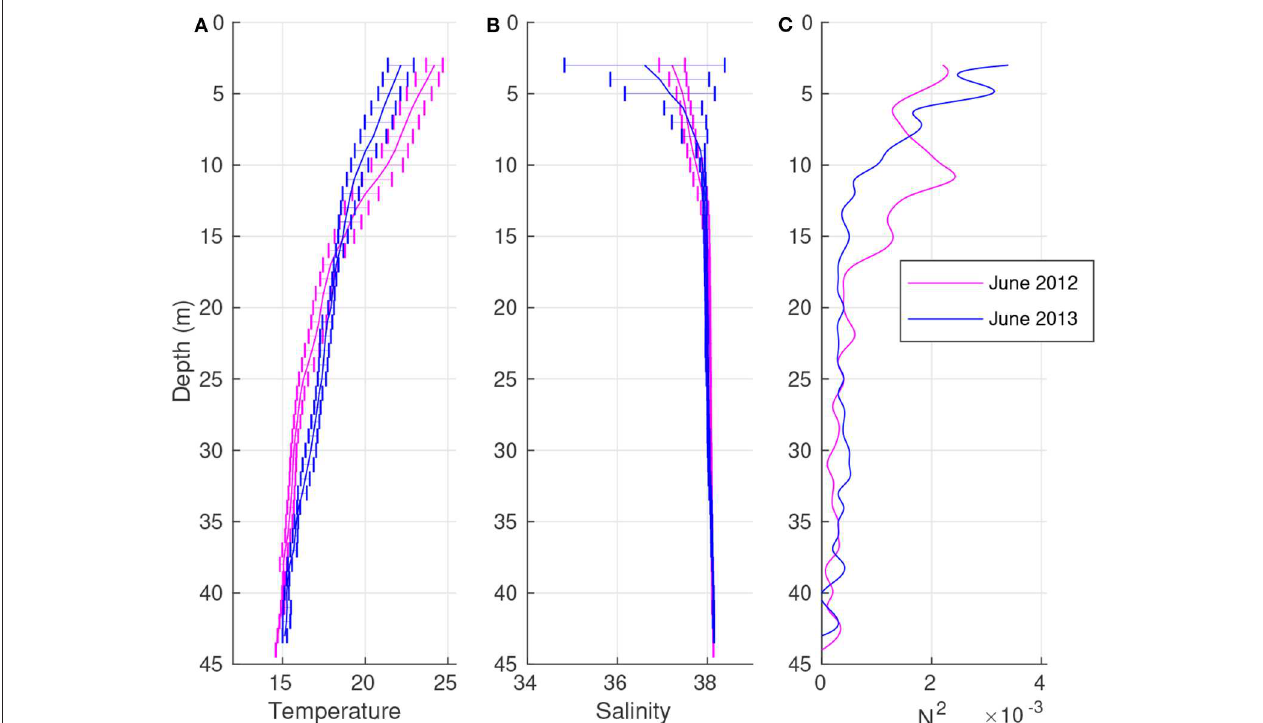
FIGURE 3 | Mean vertical profiles and standard deviations (bars) of temperature ( A ; ◦ C), salinity ( B ; g kg − 1 ), and the squared Brunt-Väisälä frequency [ C ; ( s − 2 )] in June 2012 (purple line) and June 2013 (blue line).